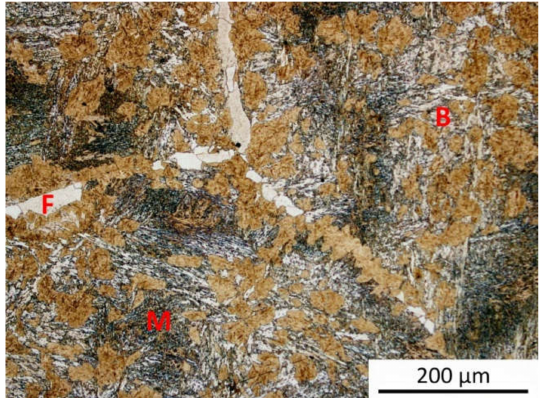
Figure 6. Structure of the sample quenched from a heating temperature of 770 ◦ C; light microscopy.